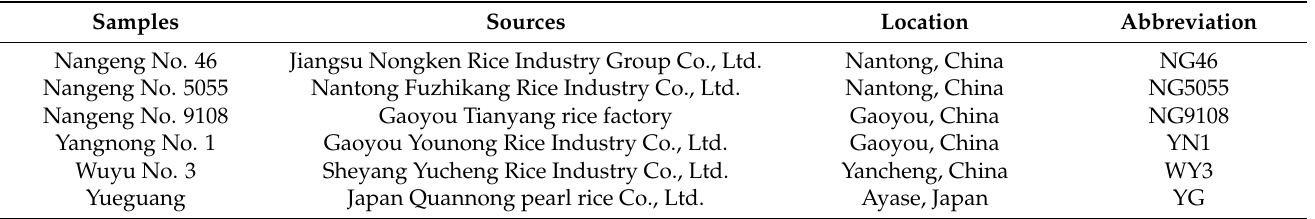
Table 1. Basic information for six kinds of Japonica rice applied in this